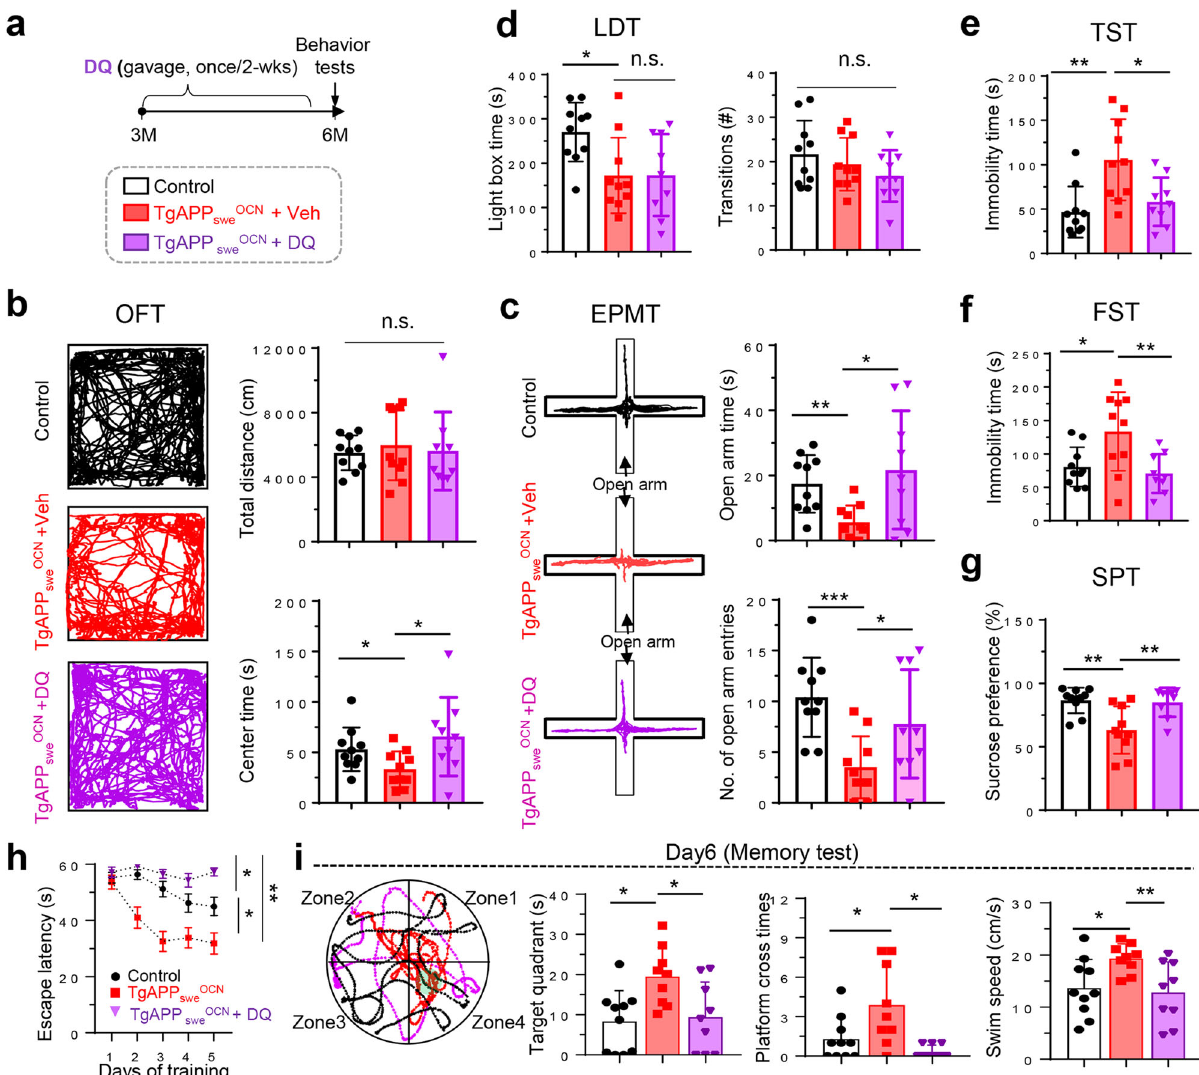
Fig. 7 Diminished behavior phenotypes in TgAPP swe OCN mice treated with senescence inhibitors. a Schematic diagram of experimental design. 6-MO control ( LSL-APP swe , n = 10 males) and TgAPP swe OCN mice were treated with Veh (10%PEG 400) ( n = 10 males) or DQ (D 5 mg/kg, Q 50 mg/kg, dissolved in 10% PEG 400, once per two weeks) ( n = 9 males), starting at age of 3-MO, and then subjected to indicated behavior tests at 6-MO. b OFT: Representative tracing images and quanti fi cations of the total distance and the center duration time were shown. n.s. not signi fi cant, * p < 0.05. c EPMT: Representative tracing images and quanti fi cations of the open arm duration time and entries were shown. * p < 0.05, ** p < 0.01, *** p < 0.001. d LDT: Quanti fi cations of the time spent in the light room and the number of transitions into the light room were shown. n.s. not signi fi cant, * p < 0.05. e TST, f FST, and g SPT were shown. * p < 0.05, ** p < 0.01. h – i MWM: the latency to reach the hidden platform during the training period ( h ), and representative tracing image and quanti fi cation of the time spent in the target quadrant, platform crossing time and swim speed ( i ) were shown. * p < 0.05, ** p < 0.01. One-way ANOVA followed by Tukey post hoc test. All data were presented as mean ±